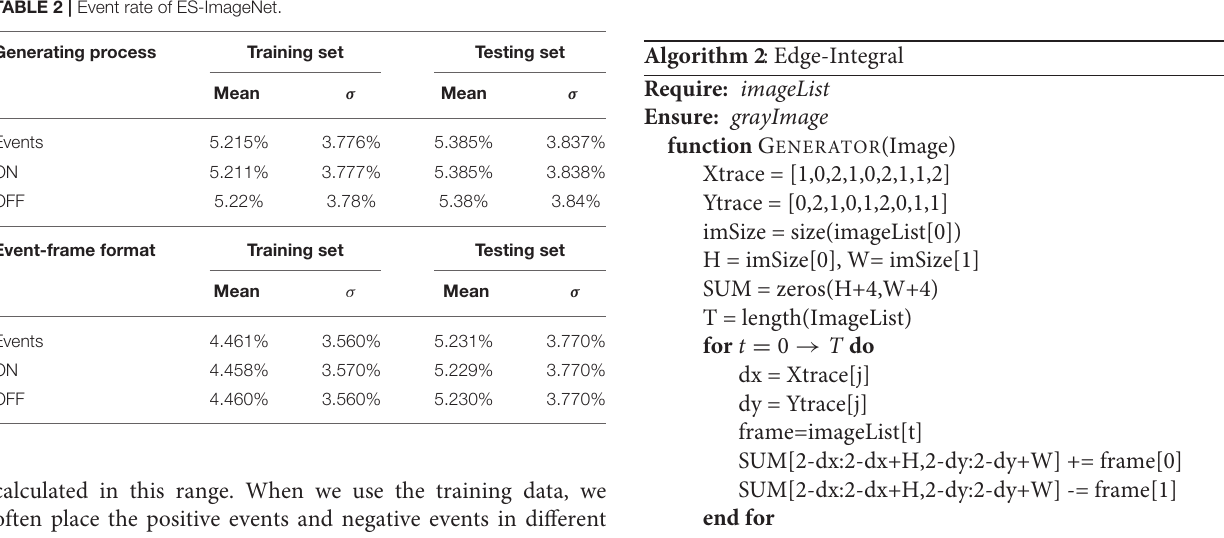
TABLE 2 | Event rate of